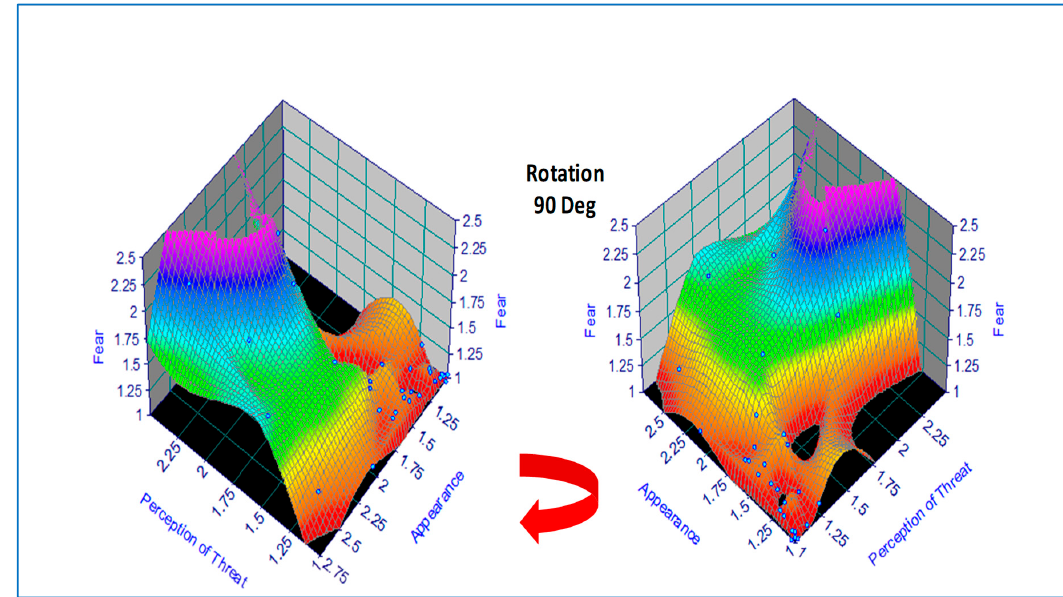
Figure 2. Illustrative example of a response surface for fear as a function of perception of threat and appearance of threat. Visualization reveals discontinuities (two black holes in the right image) exposing regions of zero-fear response under certain combinations of appearance and perception of threat.